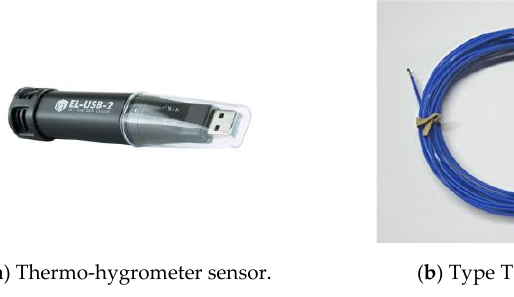
Figure 3. Different equipment used to record temperature.